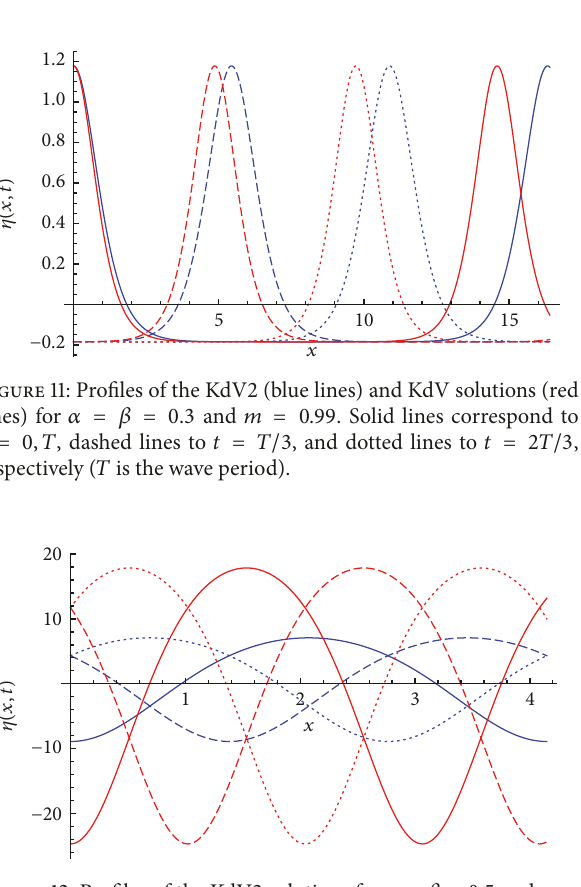
Figure 12: Profiles of the KdV2 solutions for 𝛼 = 𝛽 = 0.5 and 𝑚 = 0.05 (blue lines) and for 𝛼 = 𝛽 = 0.3 and 𝑚 = 0.1 (red lines). Solid lines correspond to 𝑡 = 0, 𝑇 , dashed lines to 𝑡 = 𝑇/3 , and dotted lines to 𝑡 = 2𝑇/3 , respectively ( 𝑇 is the wave period corresponding to the